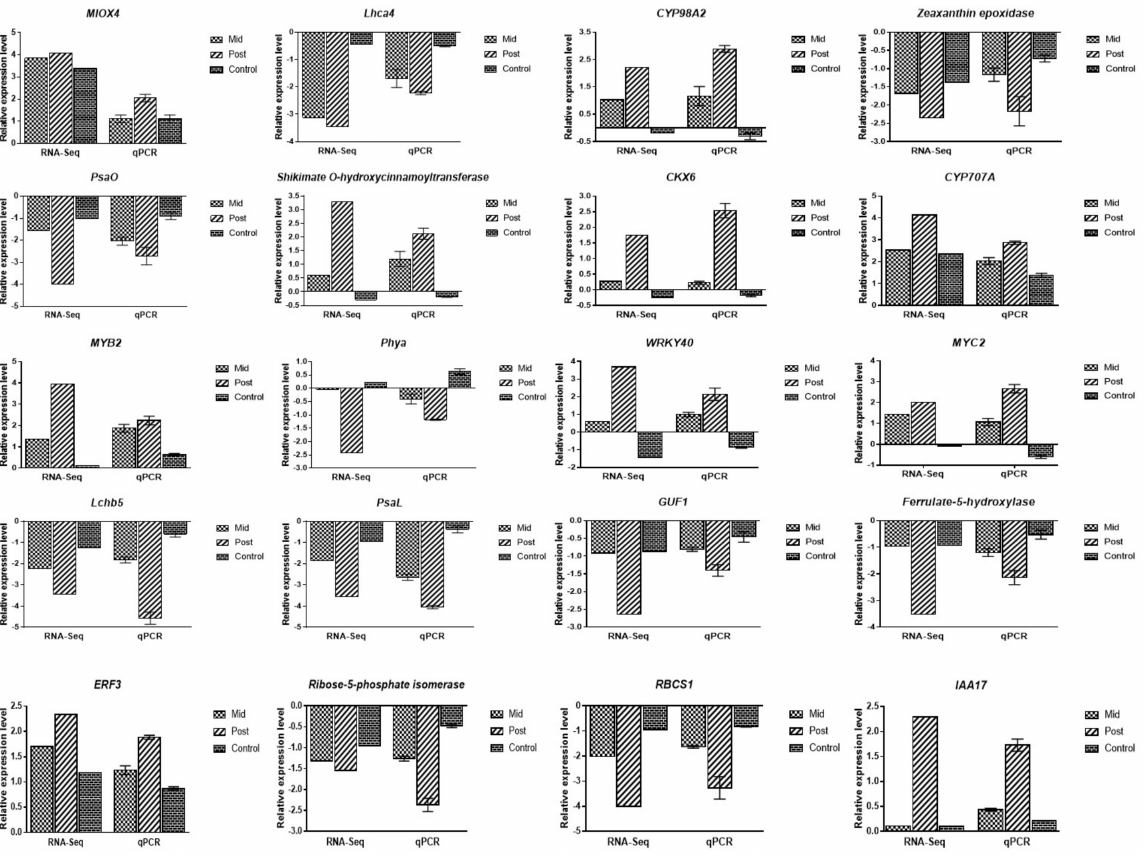
Figure 8. qRT–PCR of selected genes for the validation of RNA-seq data in mid-blanching, post-blanching, and control conditions. The black bars on the qPCR data represent the means ±